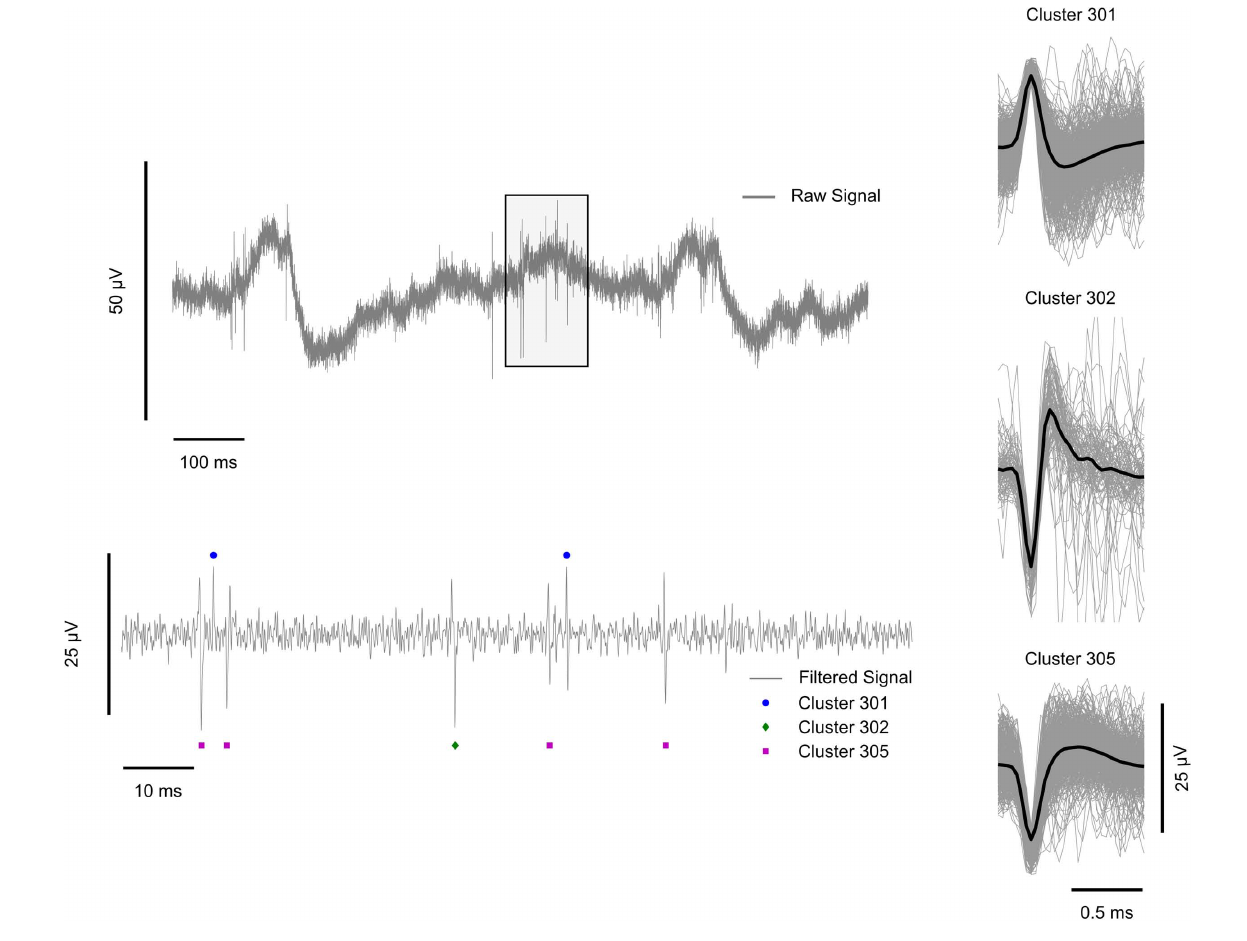
Figure 2 | illustration of extracellular recording preprocessing steps. Left: (top) 1000 ms sample of the wideband (1–9000 Hz) signal. The shaded box region is 100 ms long and is shown zoomed-in and filtered between 300 and 6000 Hz below; (bottom) 100 ms zoomed-in band-pass filtered signal with marked clustered spike events. Circles represent cluster 301, diamonds cluster